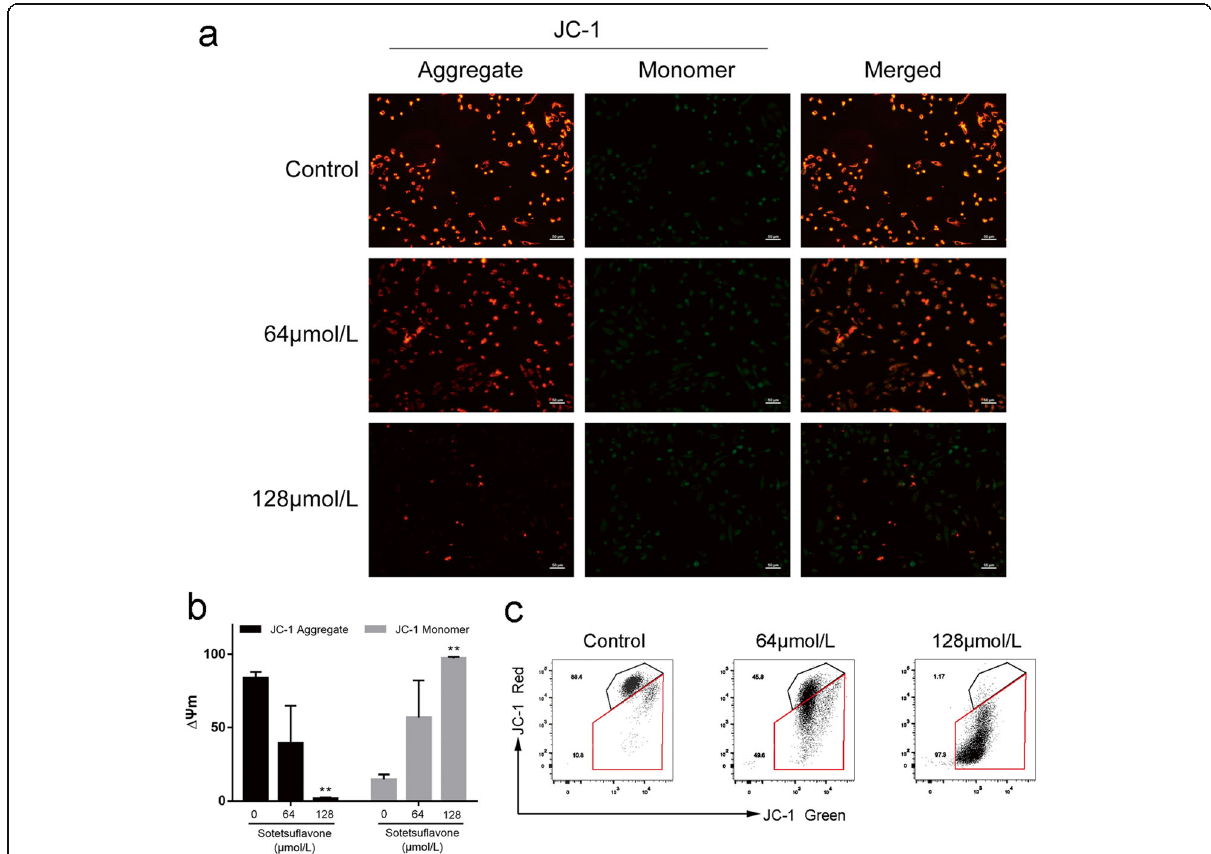
Fig. 5 Sotetsuflavone reduces mitochondrial membrane potential of A549 cells. a JC-1 fluorescence. b Changes of mitochondrial membrane potential after drug treatment. JC-1 Red channel; normal membrane potential cells. JC-1 Green channel; membrane potential collapse of cells. c Change of mitochondrial membrane potential after drug treatment. The results from three independent experiments were expressed as mean ± SD compared with the control group, ** P <